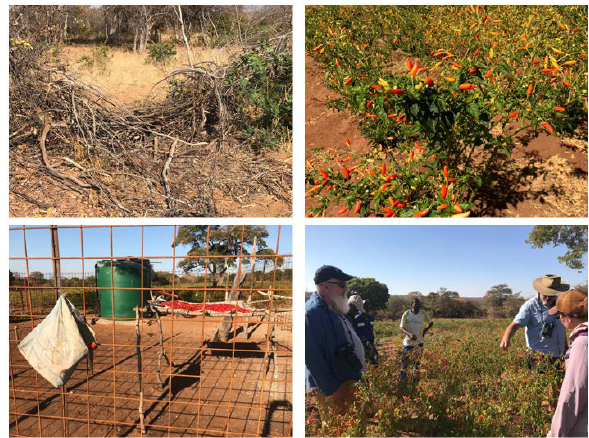
Figure 3 . GPS tracks of a bull elephant in Victoria Falls show the Figure 1. To mitigate elephants raiding local crops, farmer plant chilli behaviour of Bull 2 immediately following chili mitigation measures to peppers used to extract capsium oleoresin oils and make a mash that is prevent future human-elephant rubbed on darted elephants.